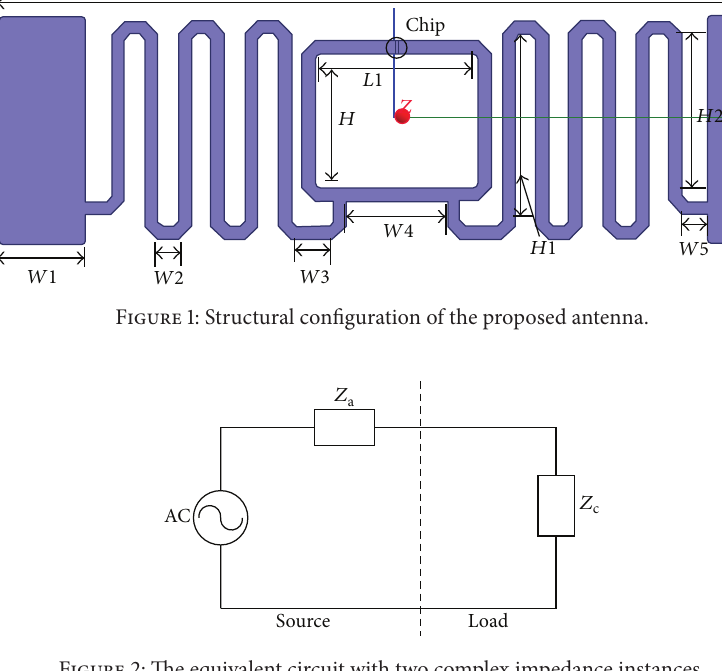
Figure 2: The equivalent circuit with two complex impedance